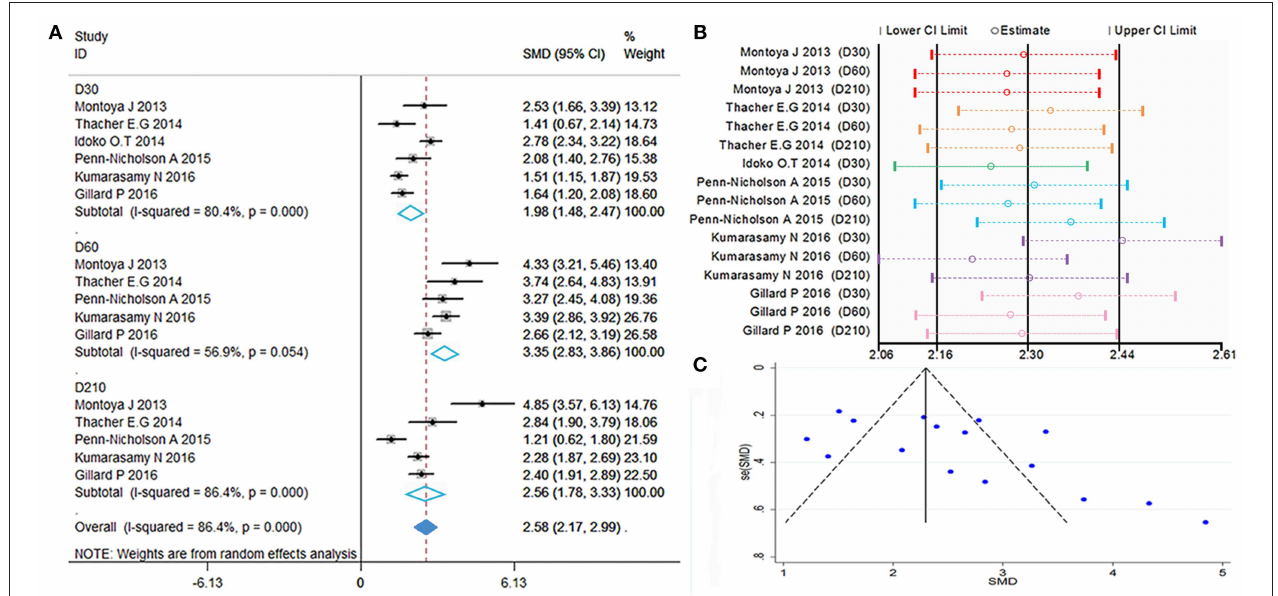
FIGURE 2 | Polyfunctional M72-specific CD4 + T-cell evaluation. (A) Forest plot: a SMD > 0 indicates that vaccine can effectively stimulate the growth of polyfunctional CD4 + T-cells. SMD = 0, invalid result. Point estimates and 95%CI are shown for each study and for the pooled results. (B) Influence analysis, examine the impact of a study on the total combined effect. The vertical solid line in the middle indicates the total combined effect, while the left and right vertical solid lines indicate 95%CI. (C) Funnel plot: the publication bias was independently assessed by determining the symmetrical distribution of the